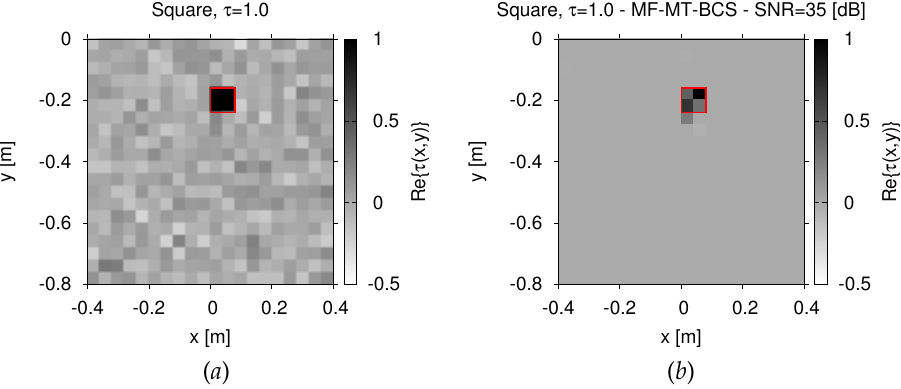
Figure 6. Numerical assessment (“ Square-Shaped ” Scatterer , τ = 1.0, N = 400, SNR = 35 dB)—Actual ( a ) and retrieved ( b ) dielectric profile by the MF-MT-BCS when considering a randomly-varying inhomogeneous soil